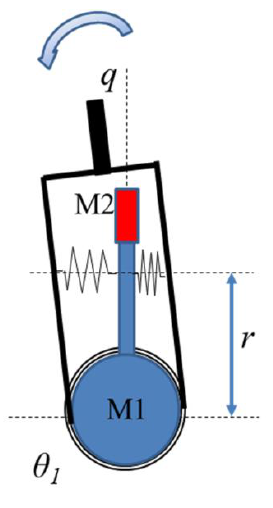
Figure 6. Series class of stiffness adjustment mechanism based on changing the spring’s position (lever